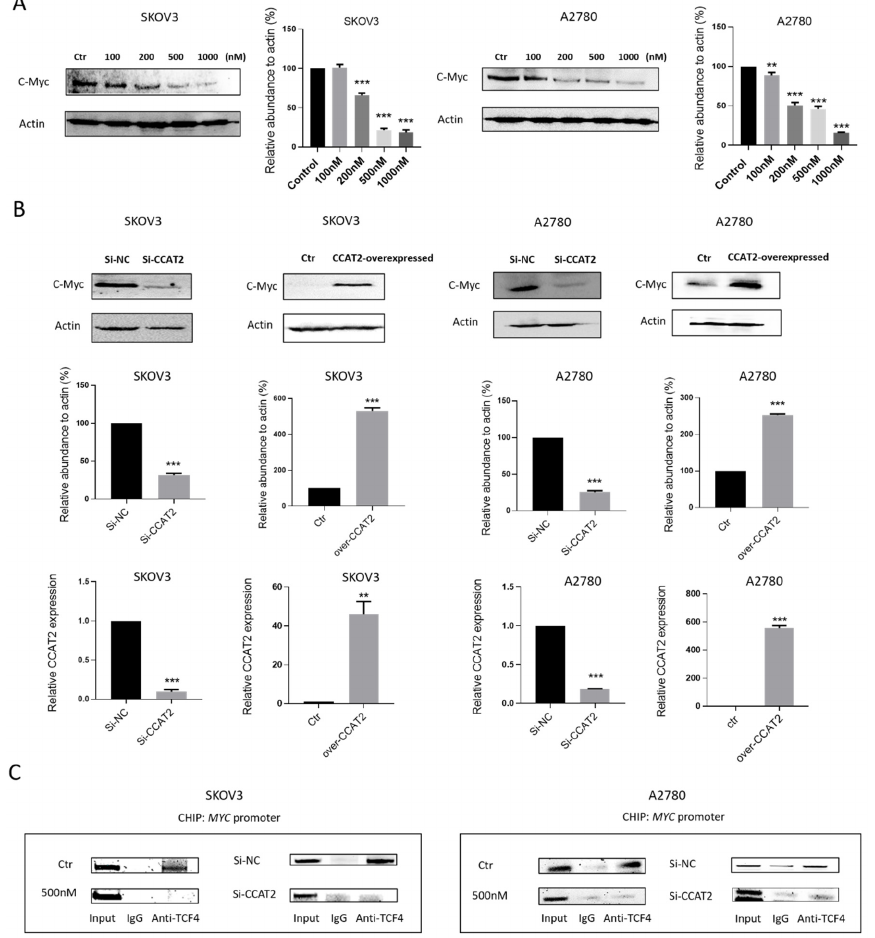
Figure 6. Calcitriol inhibited the expression of c-Myc by down-regulation of CCAT2. ( A ) SKOV3 and A2780 cells were treated with vehicle (0.1% DMSO), 100 nM, 200 nM, 500 nM and 1000 nM of calcitriol for 48 h. The expression level of c-Myc protein was examined using Western blot. ( B ) SKOV3 and A2780 were transfected with CCAT2 targeting siRNA or CCAT2-overexpressed plasmid. After 24 h, the level of CCAT2 was determined using Real-Time PCR. After 48 h, the expression level of c-Myc protein was examined using Western blot. ( C ) SKOV3 and A2780 cells were transfected with CCAT2 targeting siRNA or treated with 500 nM calcitriol. Binding of TCF4 to the MYC promoter was detected using ChIP assays as described in the Materials and Methods section. The expression level of MYC promoter was quantified using electrophoretic gels. (**) p < 0.01; (***) p < 0.001. 3. Discussion Ovarian cancer is a deadly disease and its low five-year survival rate is due to the aggressive nature of metastasis. Once the cancer metastasizes, it is resistant to chemotherapy drugs and there is no effective treatment. In this study, we found that a low dose of calcitriol has a modest inhibitory effect on ovarian cancer cell proliferation. Notably, calcitriol exerts significant activity against the migration and invasion of ovarian cancer cells. The results suggest that vitamin D treatment may be